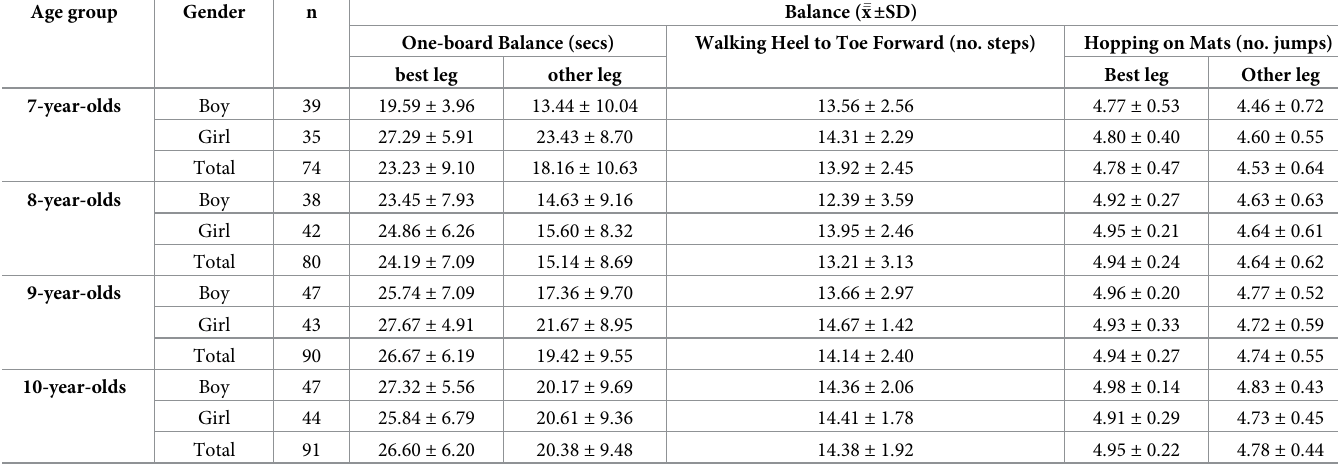
Table 4. Movement performance in the Balance subtest of each age group (n = 335). Age group